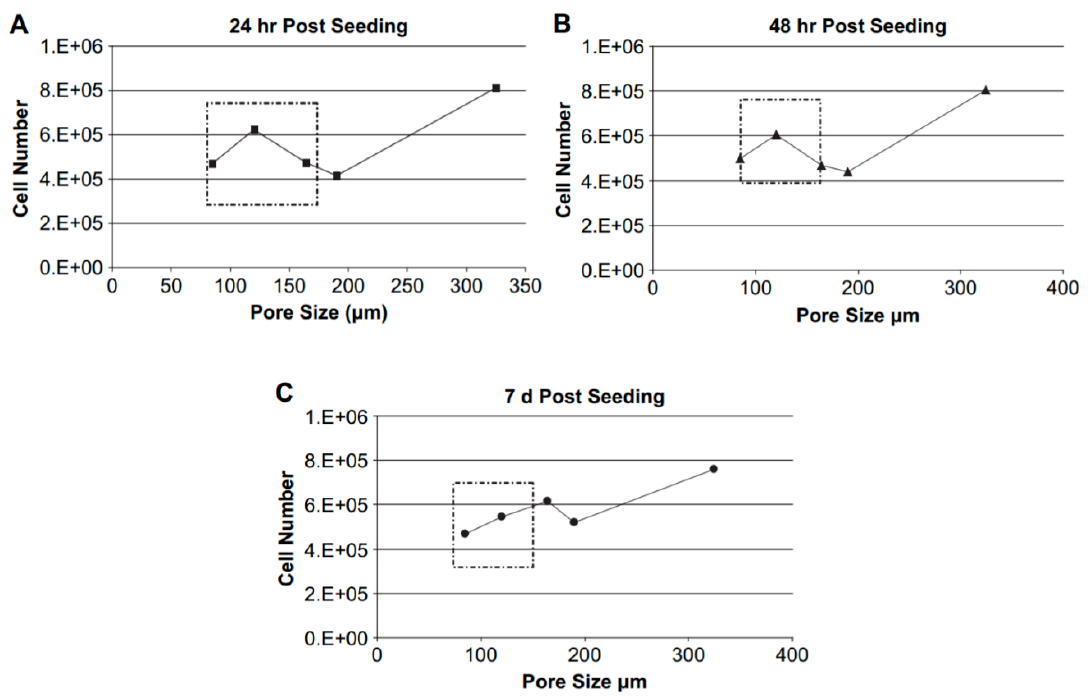
Figure 6. Effect of mean pore size of collagen-glycosaminoglycan scaffolds on MC3T3-E1 cell attachment and proliferation at different time points: at 24h ( A ), at 48h ( B ) and 7 days ( C ). The relation between mean pore size and cell response is non-linear (reprinted from [198], with permission from Elsevier).